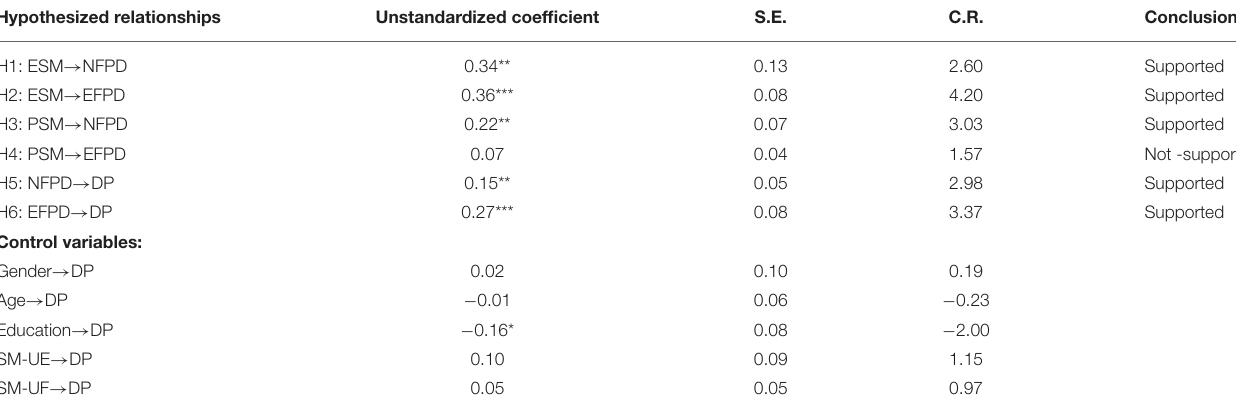
TABLE 5 | Results of the structural model. Hypothesized